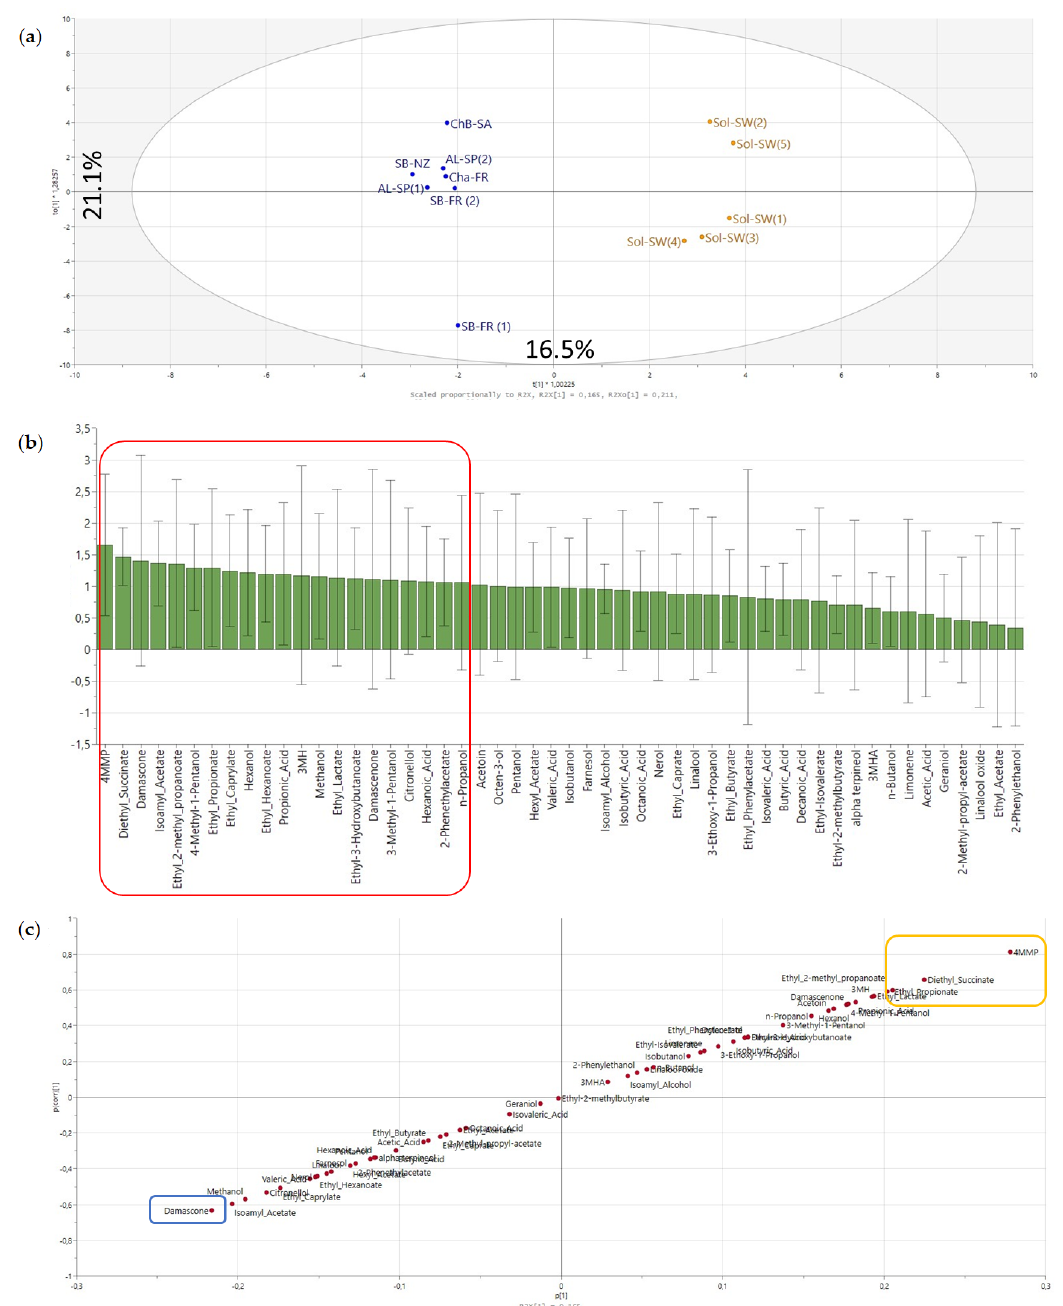
Figure 5. OPLS-DA score plot ( a ), VIP (Variable Importance for Projection) ( b ) and S-plot pair wise comparison ( c ) between Solaris (colored in orange) and non-Solaris wines (colored in blue) according to their volatile composition. Squares on the S-plot represent the significant variables for Sol and non-Sol based on the Student ’s t -test.